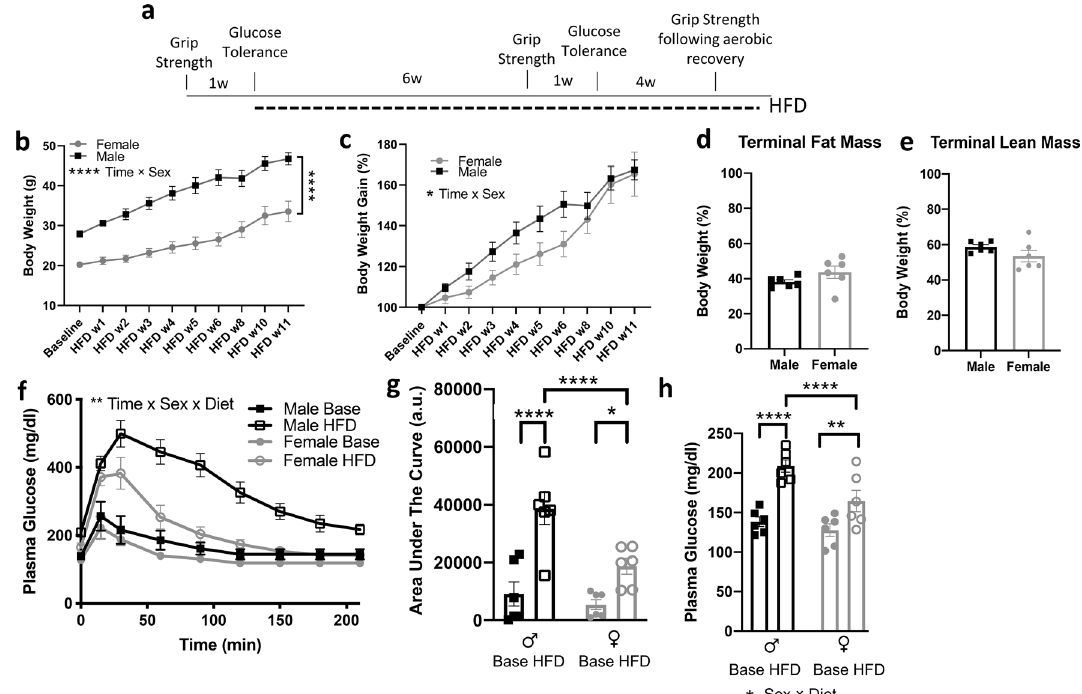
Figure 4. Diet-induced weight gain and glucose intolerance in males and females. ( a ) Experimental design for high-fat diet (HFD) administration and assessment of metabolic and muscle parameters. ( b ) Raw body weight of animals across experimental timeline (****p < 0.0001 time × sex interaction, two-way repeated measures ANOVA; n = 6/sex). ( c ) Body weight gain in male and female mice fed HFD (*p < 0.05, time × sex interaction, two-way ANOVA). ( d , e ) Similar proportional fat and lean mass in HFD males and females. ( f ) Glucose tolerance curves in males and females at baseline (Base) and following HFD. Males show greater glucose intolerance than females in response to HFD (**p < 0.01, time × sex × diet interaction, three-way repeated measures ANOVA). ( g ) Integrated glucose clearance is significantly increased following HFD, and higher in males compared to females (*p < 0.05, ****p < 0.0001, two-way ANOVA, Tukey’s multiple comparison post-hoc test). ( h ) Plasma glucose is elevated in response to HFD compared to baseline (measured following a 5 h fast), and higher in males than females (**p < 0.01, ****p < 0.0001; *p < 0.05, sex × diet interaction, Tukey’s post-hoc test, two-way